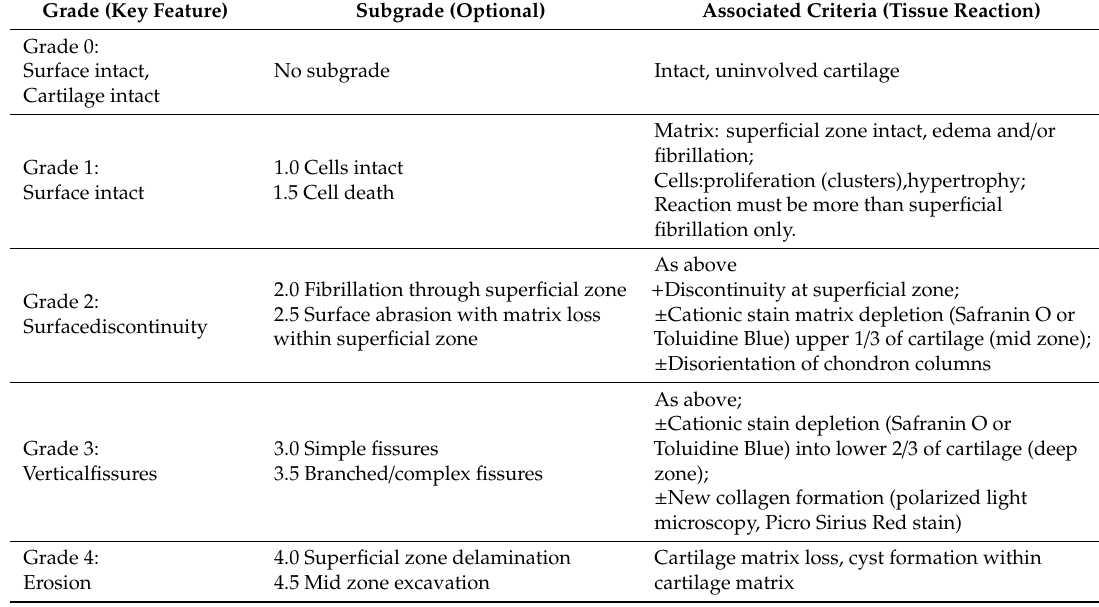
Table 4. Osteoarthritis cartilage histopathology assessment classification system (Osteoarthritis Research Society International)